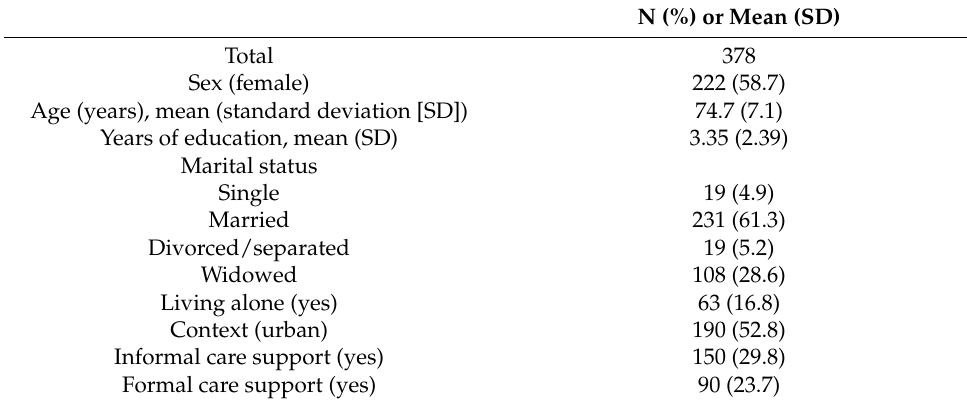
Table 2. Sociodemographic characteristics of the